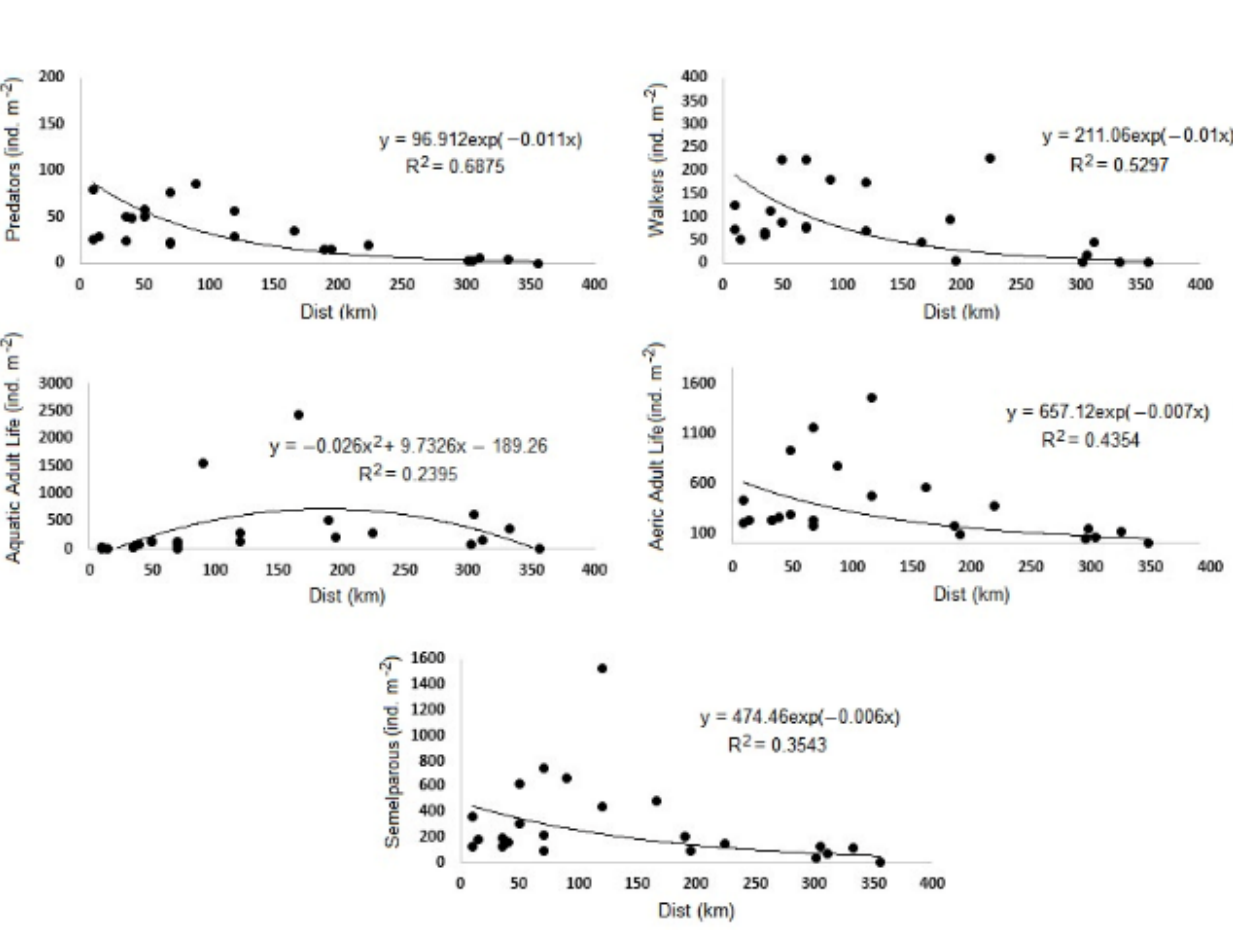
Table 5. Most fitted regression models between distance from the source and biological traits.